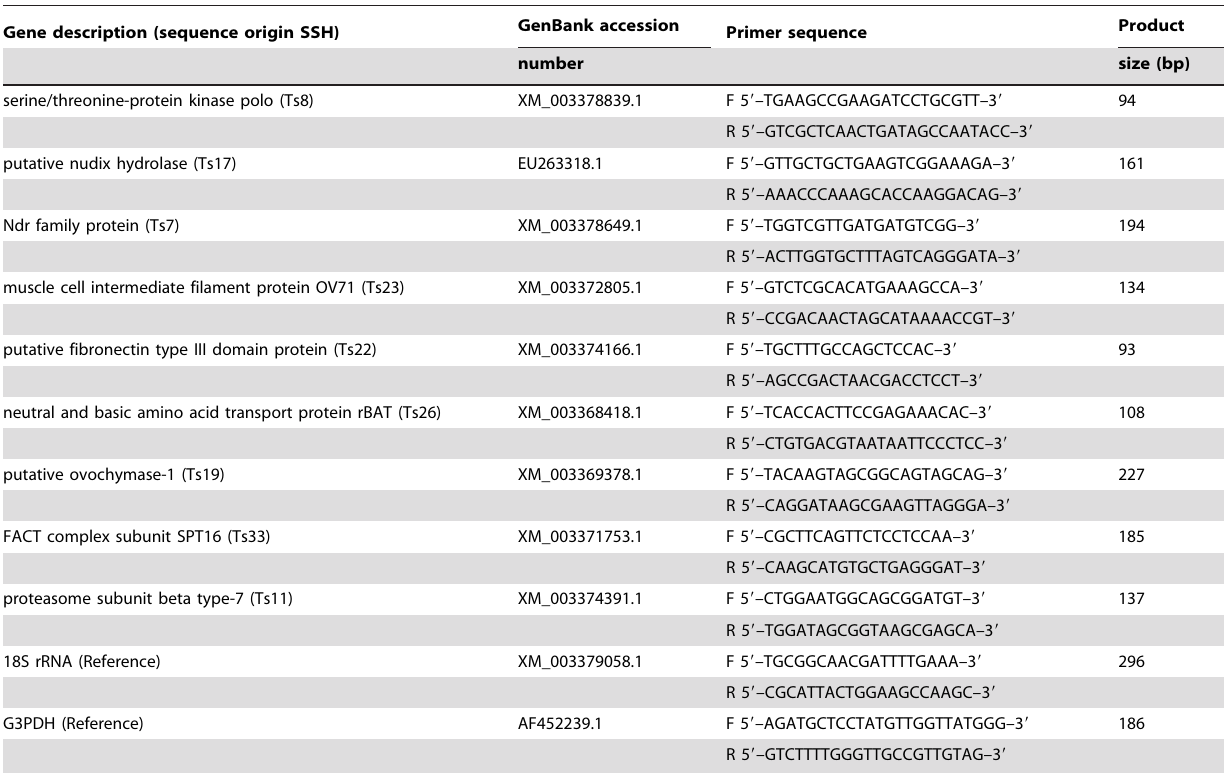
Table 1. Primers used in the real-time PCR